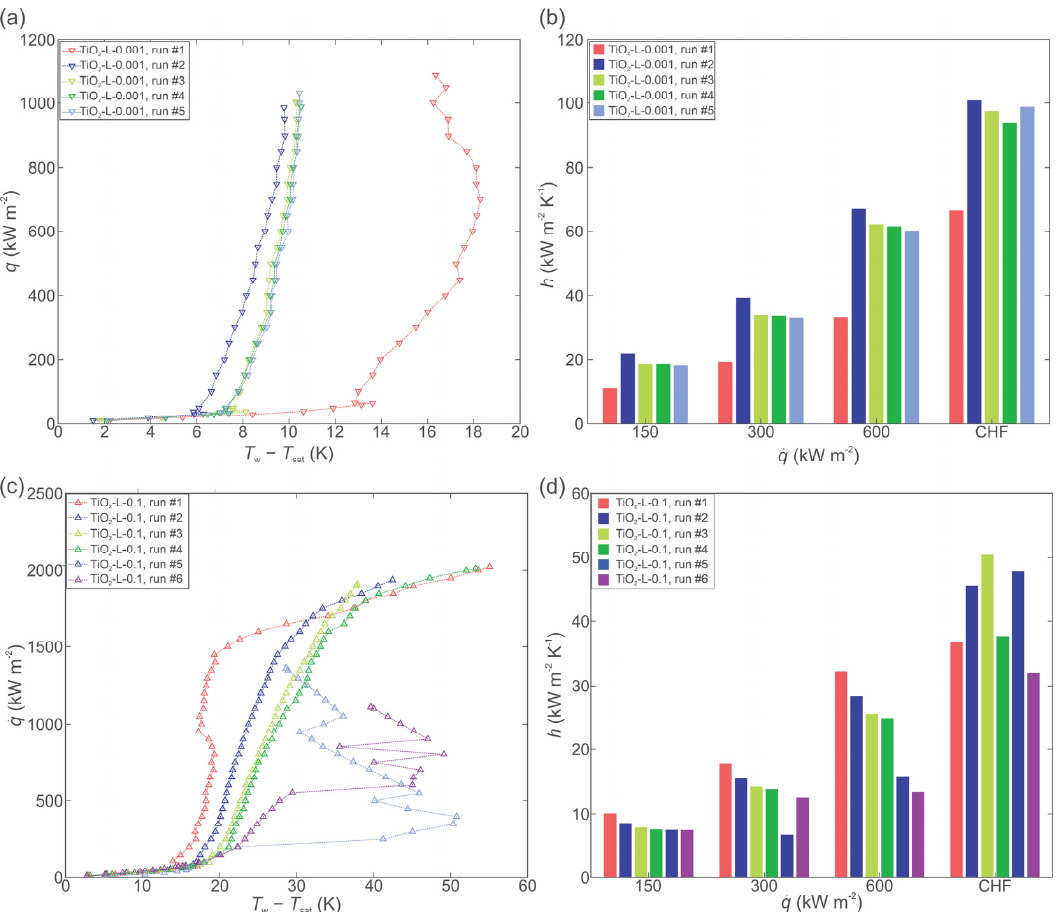
Figure 7. Boiling of TiO 2 -water nanofluid with large size nanoparticles at 0.001 wt.%: boiling curves ( a ) and heat transfer coefficients ( b ). Boiling of TiO 2 -water nanofluid with large size nanoparticles at 0.1 wt.%: boiling curves ( c ) and heat transfer coefficients ( d ).